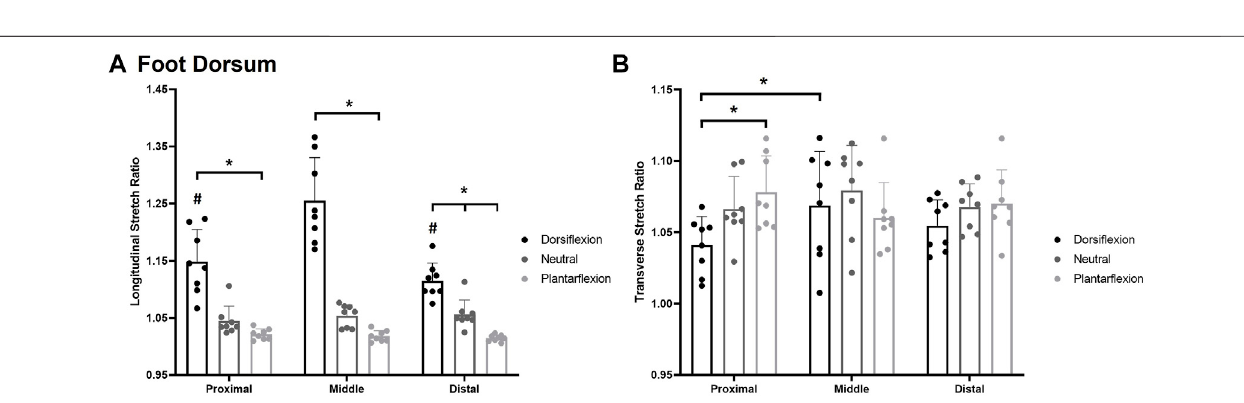
FIGURE 7 | (A) Mean (+SD) longitudinal skin stretch threshold, expressed as a stretch ratio, across each of the foot sole testing locations for each posture. Asterisks indicate statistically signi fi cant differences between the various postures at the medial arch and metatarsal ( p < 0.05). (B) Mean (+SD) transverse skin stretch threshold, expressed as a stretch ratio, across each of the foot sole testing locations for each posture. Asterisks indicate statistically signi fi cant difference from the metatarsalsiteinplantar fl exion.Poundsymbolindicatesstatisticallysigni fi cantdifferencefromthemetatarsalsiteinneutral.Triangleindicatesstatisticallysigni fi cant difference fromthemetatarsalsite indorsi fl exion( p < 0.05).Dotsrepresentthreshold valuesforeach participant. Note: anincreasein stretchratioindicates more stretch is required before the stretch is perceived.